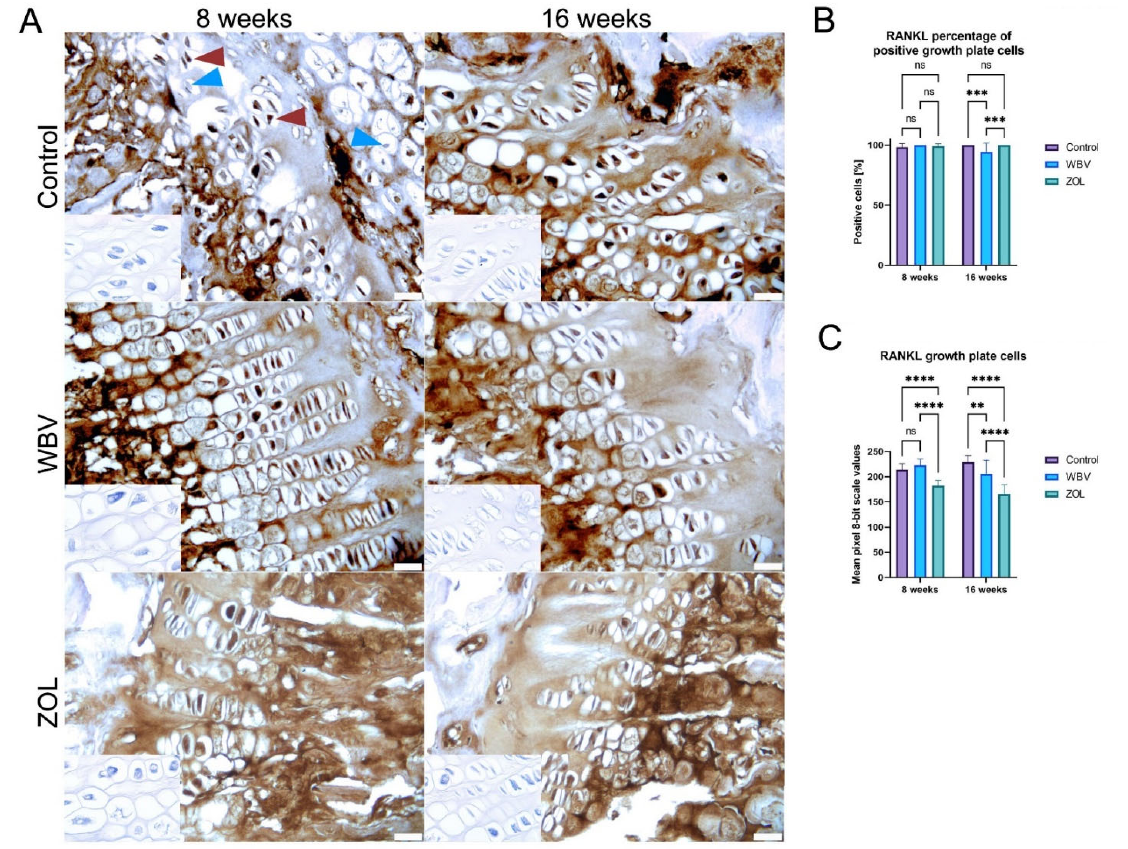
Figure 9. The immunohistochemical reaction for receptor activator for nuclear factor kappa ‐ B ligand (RANKL) in the growth plate of femora of rats subjected to obesity and immobility: ( A ) Representative images of the immunohistochemical reactions for RANKL. Brown and blue arrowheads indicate examples of positive and negative reaction cells, respectively. Insets show control immunohistochemical staining without primary antibody. All scale bars represent 50 μ m; bar graphs show ( B ) percentage of cells showing positive reaction to RANKL, and ( C ) the intensity of immunoexpression of RANKL in the growth plate cells measured by the 8 ‐ bit grayscale pixel brightness value (the higher the pixel value, the higher the intensity of the immunohistochemical reaction). Data are mean values ± SD from n = 6 rats. Control—the control group included rats subjected to obesity and immobility not treated with WBV or ZOL; WBV—the WBV group included rats subjected to obesity and immobility with whole-body vibration treatment (30 min, 5 days per week); ZOL—the ZOL group included rats subjected to obesity and immobility and injected intramuscularly with zoledronic acid at a dose of 0.025 mg/kg body weight every 4 weeks. Statistical significance: ns—not significant; ** p < 0.01; *** p < 0.001; **** p < 0.0001 (Tukey’s HSD test or Kruskal–Wallis H